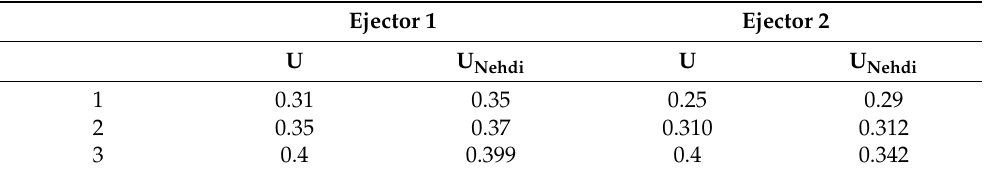
Table 8. Ejector model